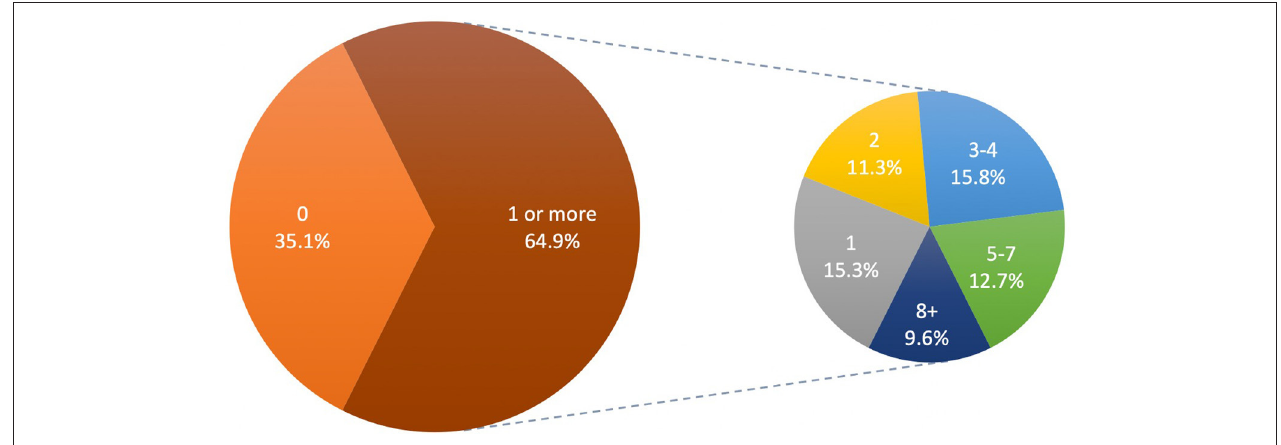
FIGURE 2 | Proportions of foods in the Branded Food Products Database ( n = 241,688) with one or more sensory-related industrial additives (SRIAs).